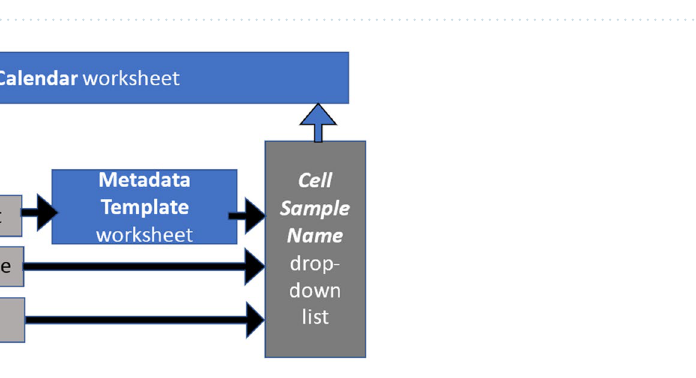
Figure 1. A schematic of the experimental process. In this use case, edited cells were selected based on expression of a fluorescent reporter, not on antibiotic resistance. Cells were transfected (I); examined for expression of edited fluorescent gene product (III); clones were expanded and enriched by iterative sorting with flow cytometry (IV-V); and analyzed (VI).